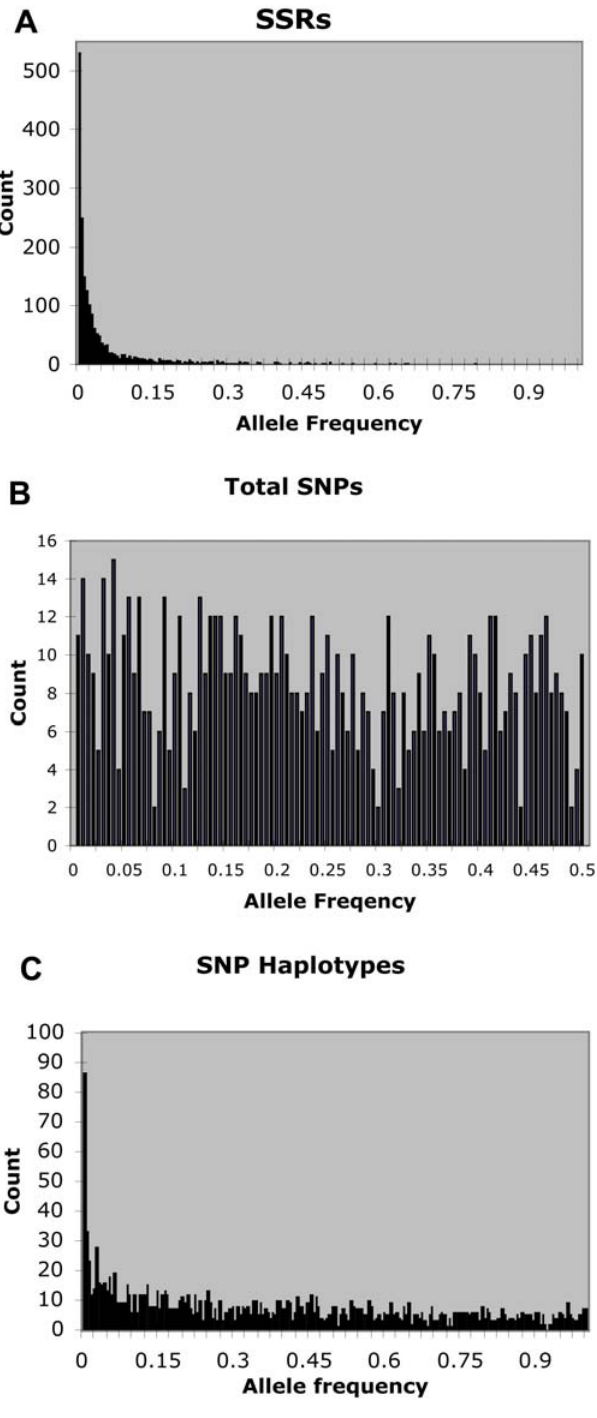
Figure 1. Allele frequency spectra for different classes of markers. Note that the scale on the x axis is different for total SNPs, because